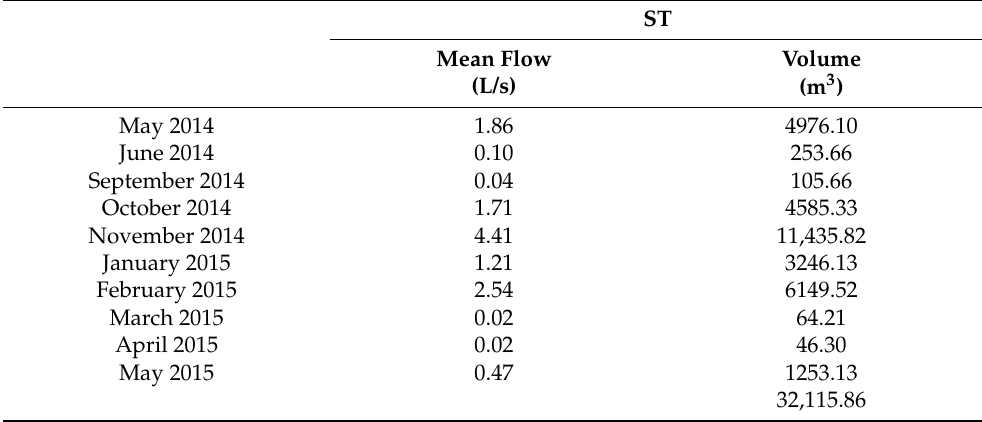
Table 4. Average monthly flow corresponding to rainfall (ST) and corresponding volumes.